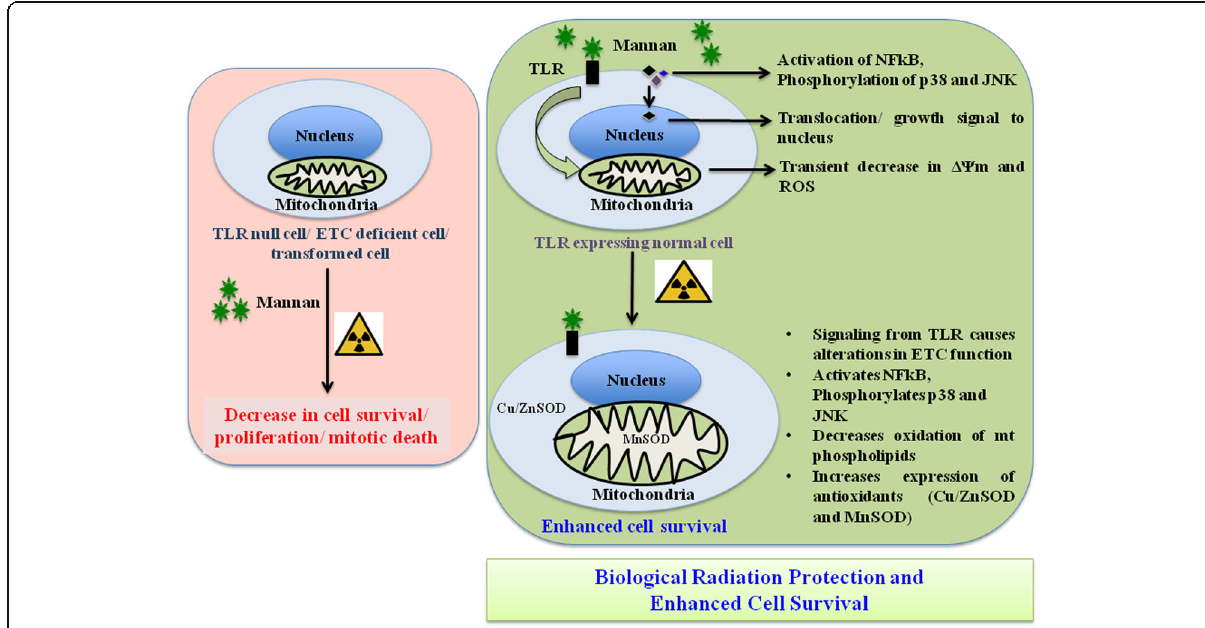
Fig. 11 Summary of mechanism of action of MOS. Cells treated with or without MOS showed altered MMP and Enhanced ROS generation. Pre-irradiation treatment of cells with MOS specifically protected normal cells, suggesting requirement of TLR and functional integrity of ETC. MOS also found to upregulate MnSOD and Cu/ZnSOD expression and activated NF κ B. All these factors might have collectively contributed towards radio-protective efficacy unveiled by